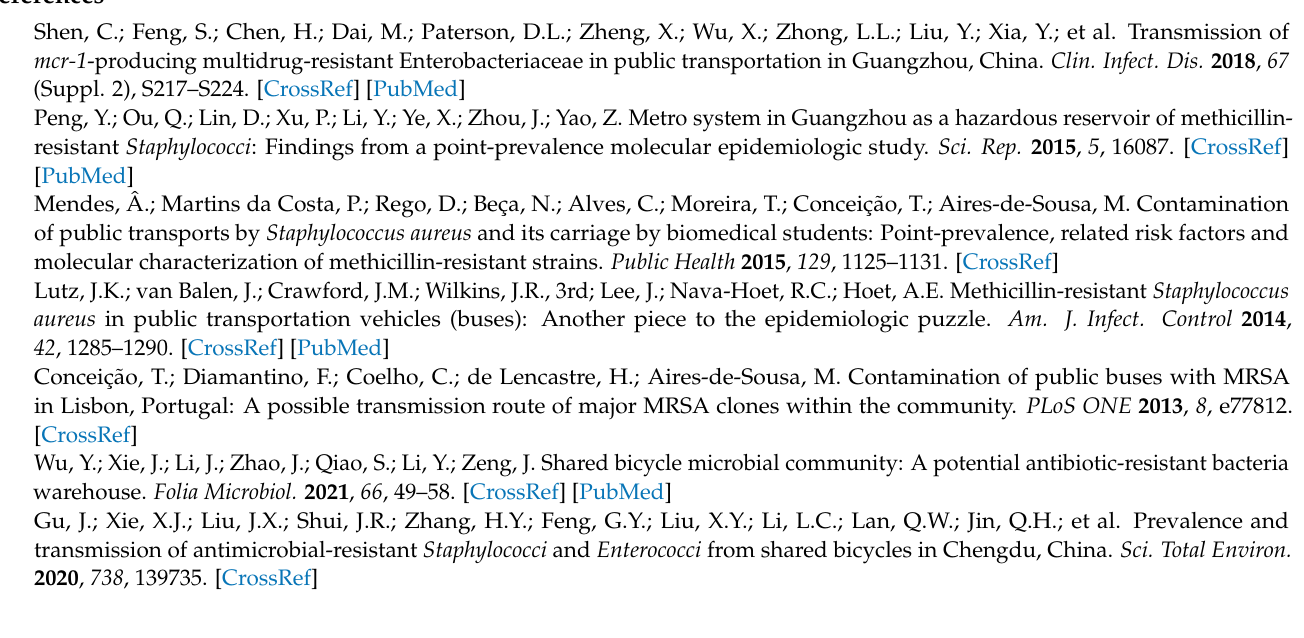
countries or districts. Table S1. The information of E. coli collected from shared bikes. Table S2.